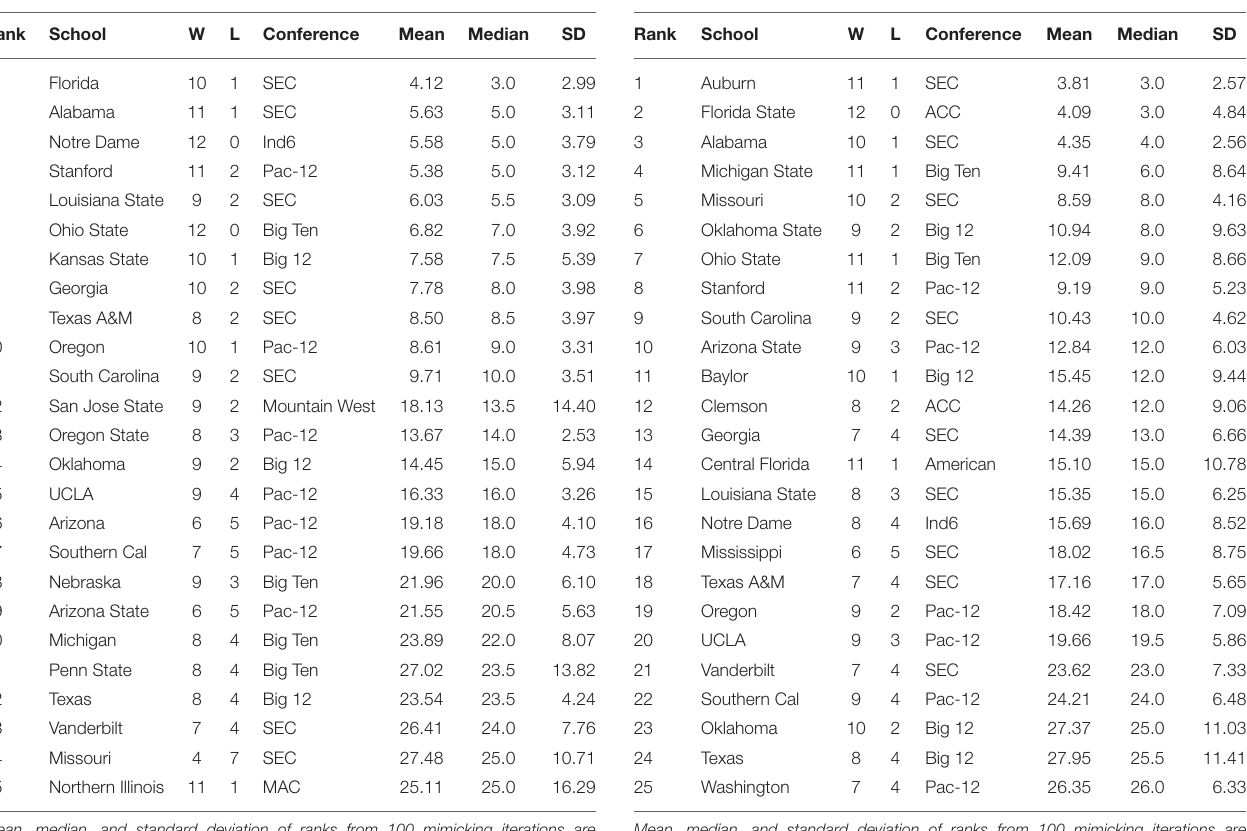
TABLE 2 | Top 25 NCAA football teams for the 2013 season as ranked with respect to microstate